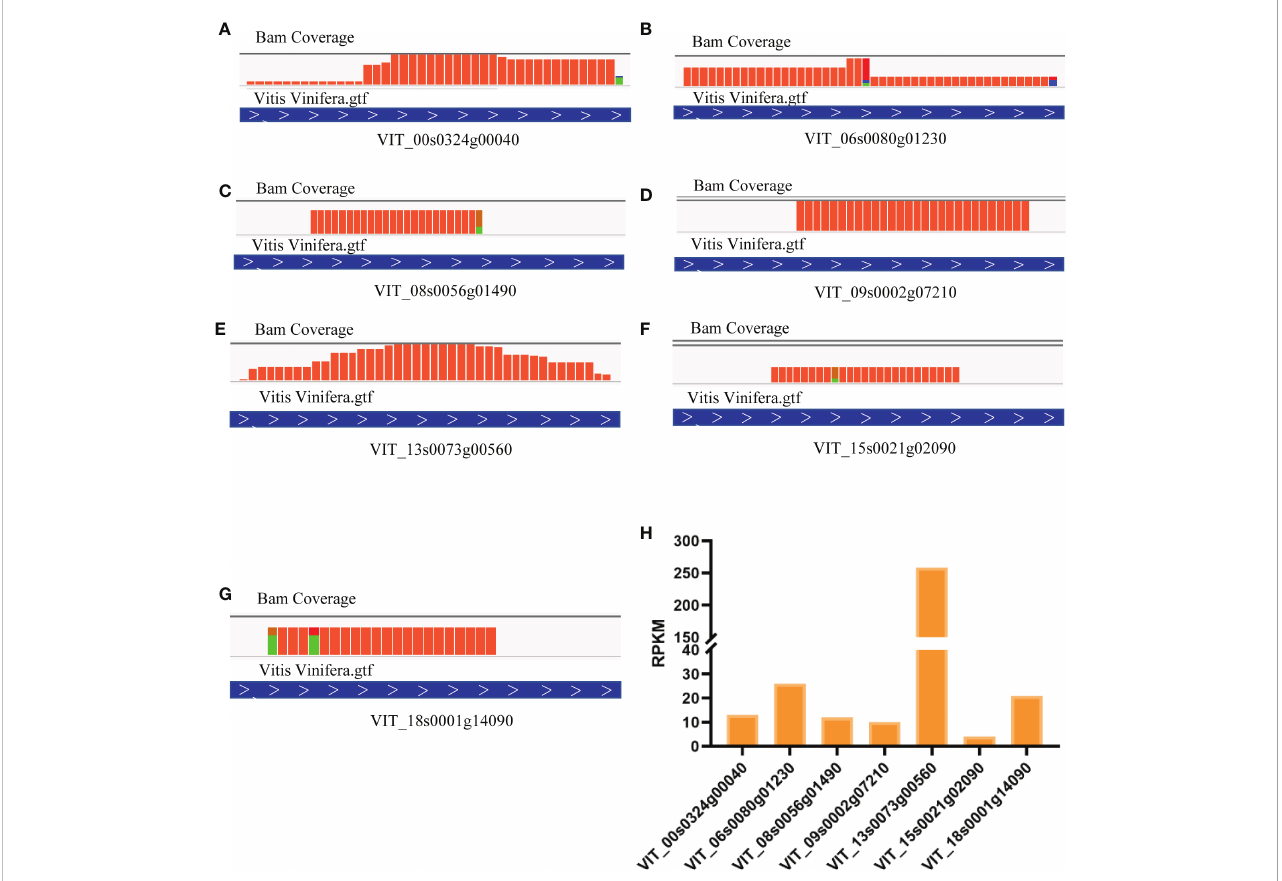
FIGURE 3 Comparation and visualization of translation ef fi ciency in heat shock binding proteins. (A) RPKM in Different heat shock binding proteins. Reads coverage in VIT_00s0324g00040 (B) , VIT_06s0080g01230 (C) , VIT_08s0056g01490 (D) , VIT_09s0002g07210 (E) , VIT_13s0073g00560 (F) , VIT_15s0021g02090 (G) , VIT_18s0001g14090 (H) .